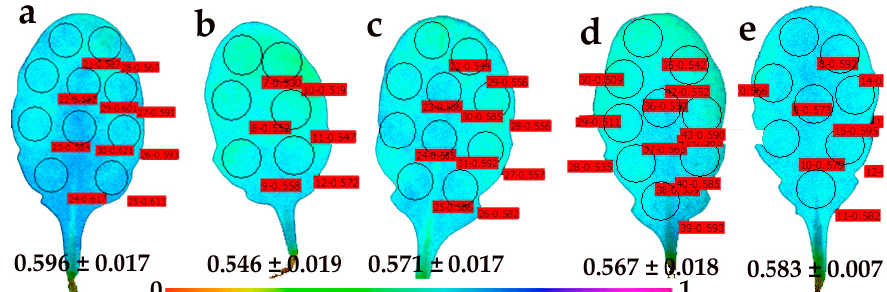
Figure 7. Representative chlorophyll fluorescence images of the e ff ective quantum yield of PSII photochemistry ( Φ PSII ) of Arabidopsis thaliana young leaves after 5 min of illumination at 140 µ mol photons m − 2 s –1 . Leaves were measured after the foliar spray with distilled water (control) ( a ), or 30 min ( b ), 90 min ( c ), 180 min ( d ) and 240 min ( e ) after the foliar spay with 30 mg L − 1 of CuZn NPs. The color code depicted at the bottom of the images ranges from values 0.0 to 1.0. The areas of interest (AOI) are shown in each image. The average Φ PSII value of all the AOI for the whole leaf is shown.